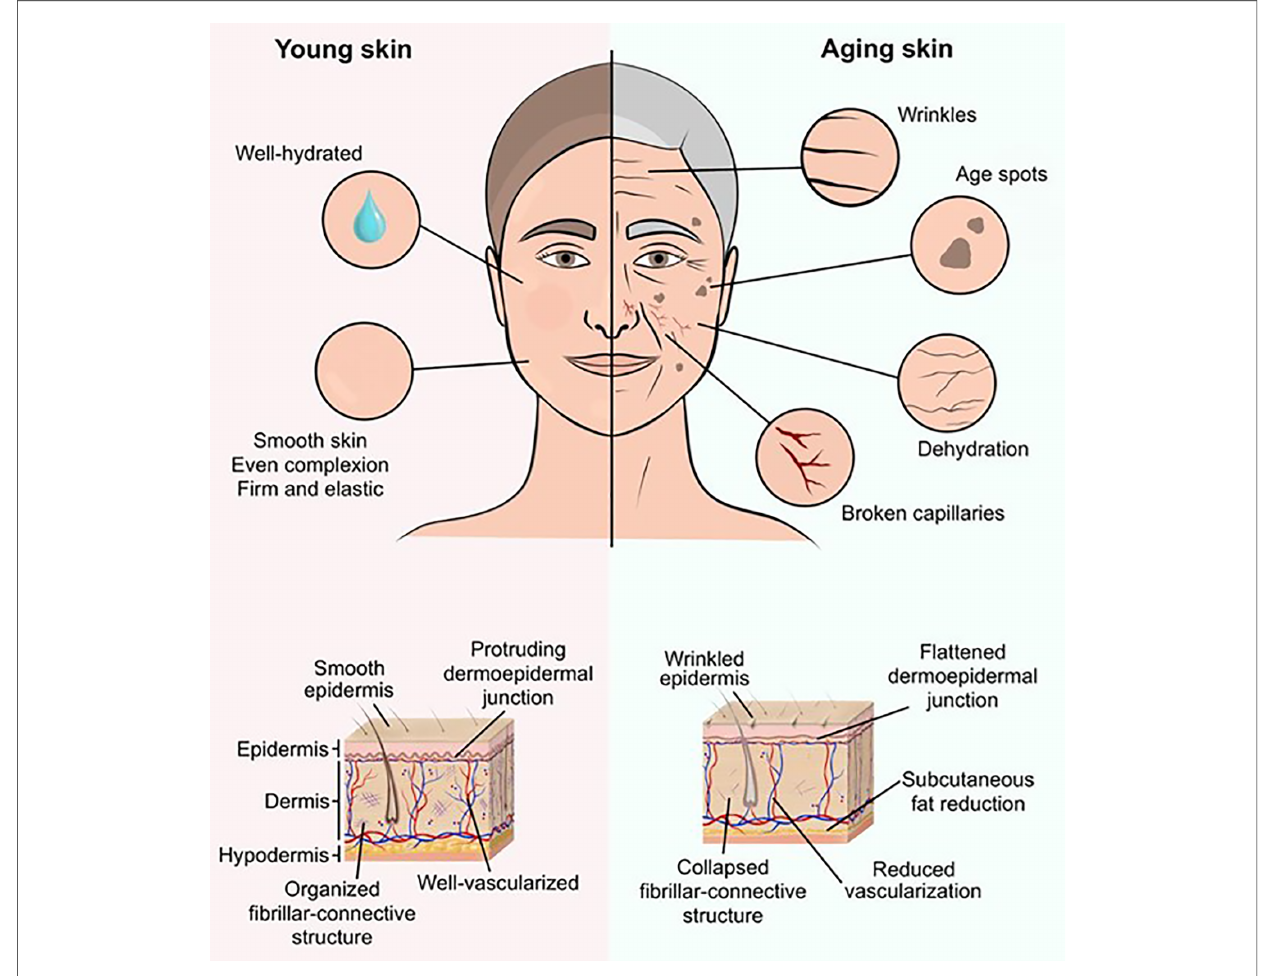
FIGURE 1 Illustrative comparison between young and aging skin. Age-related skin changes can manifest in various ways, thereby complicating free fl ap evaluation and concealing common signs of free fl ap failure. Externally, deep wrinkles, dark-pigmented age spots, and super fi cial vascular drawings re fl ect the senescence of the skin structures. On the histological level, the dermo-epidermal junction fl attens and the fi brillar-connective structure collapses. Due to a progressive subcutaneous fat reduction, decrease in water content, and loss of elasticity the impression of youthful smooth skin vanishes over